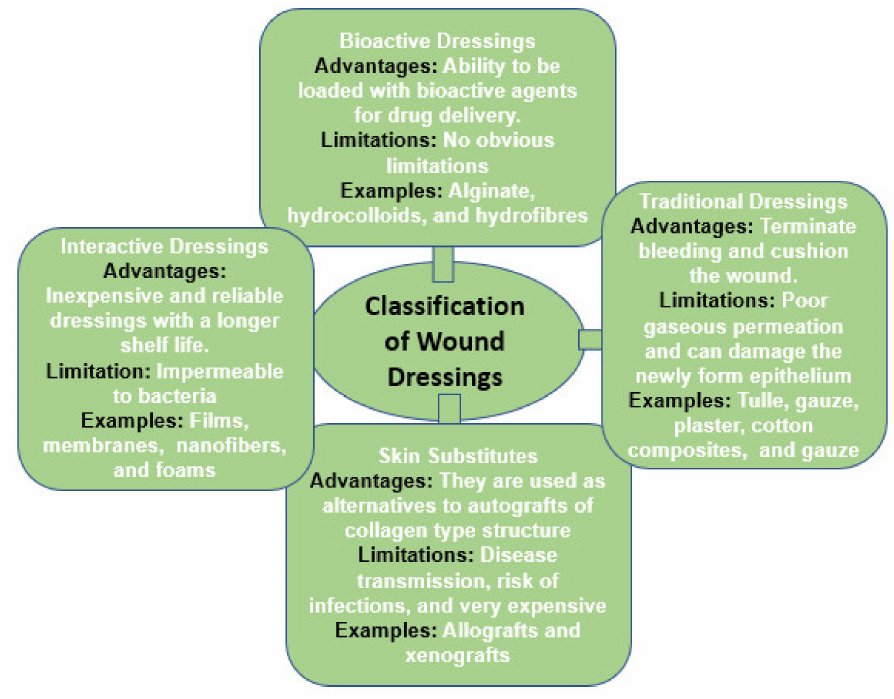
Figure 3. Classification of Wound